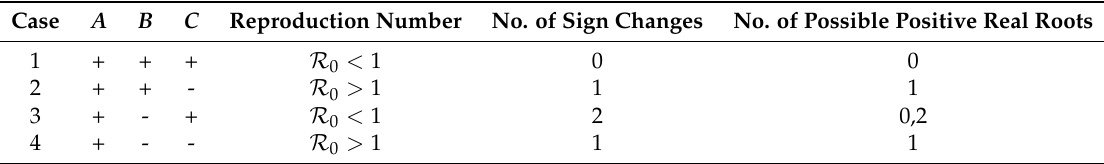
Table 2. Number of possible positive real roots of g ( i ∗ v ) given in (4) for R 0 < 1 and R 0 > 1.